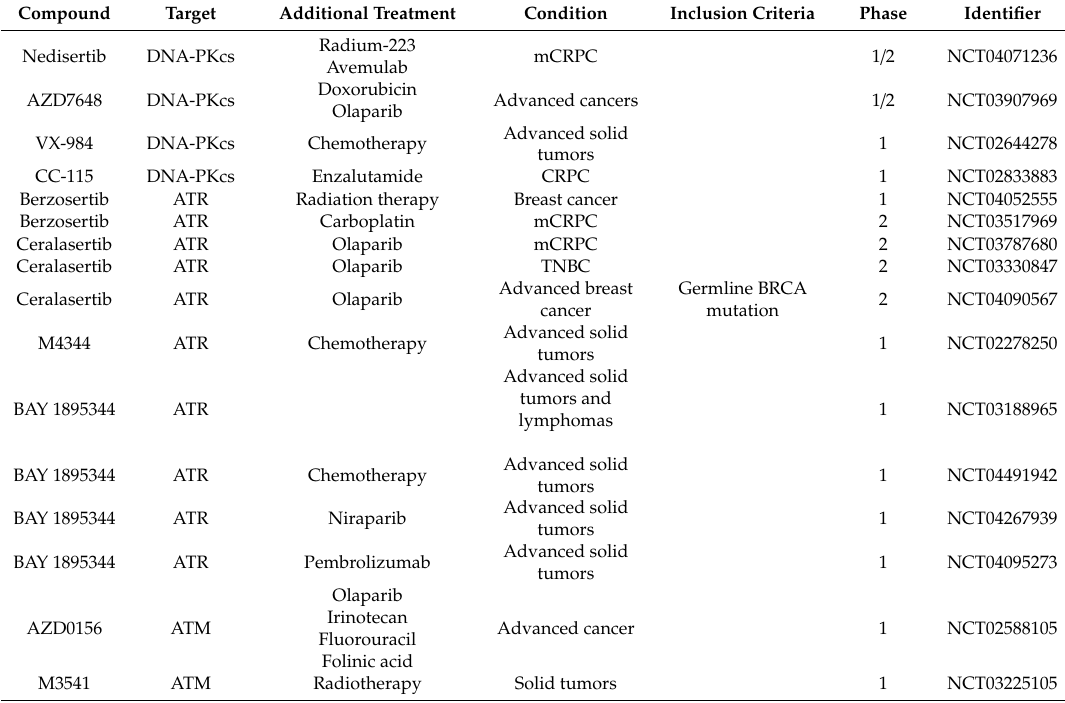
Table 2. Selected clinical trials evaluating DNA-dependent protein kinase catalytic subunit (DNA-PKcs), ataxia–telangiectasia-mutated (ATM) or ATM and Rad3-related (ATR) inhibitors in solid tumors including prostate or breast